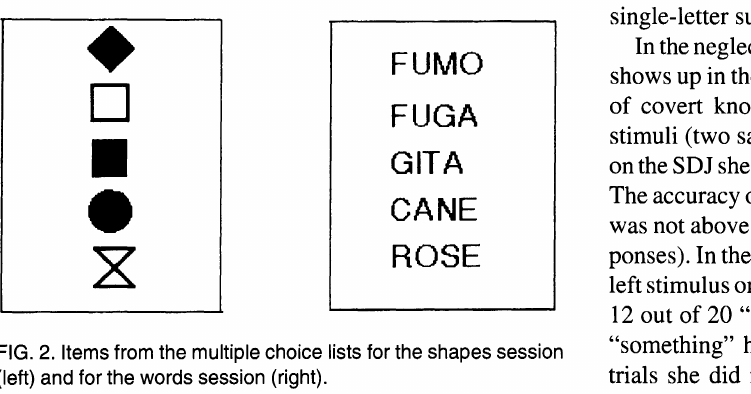
FIG. 2. Items from the multiple choice lists for the shapes session (left) and for the words session (right).